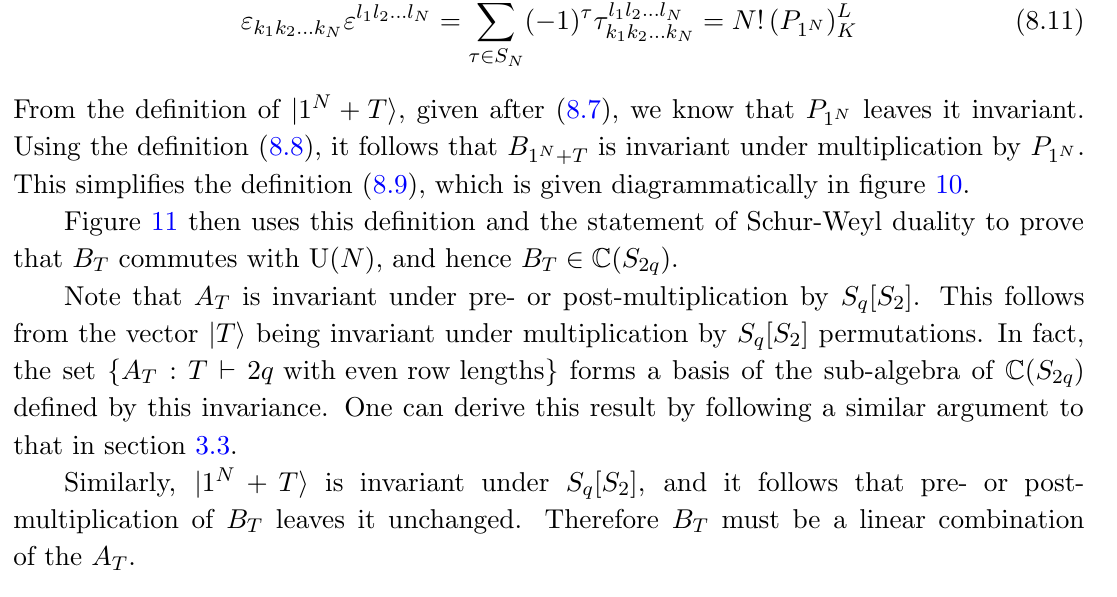
Figure 11 . Diagrammatic proof that B T commutes with U( N ). B has N + 2 q indices, which 1 N + T are split into a set of N and a set of 2 q . The two lines represent these two sets respectively. Here U stands for the diagonal action of U on the tensor space, so more properly we should write U (cid:10) N on the left hand side and U (cid:10) 2 q on the right hand side. The central equality follows from Schur-Weyl duality, which implies U (cid:10) N +2 q commutes with B , and the cyclicity of 1 N + T